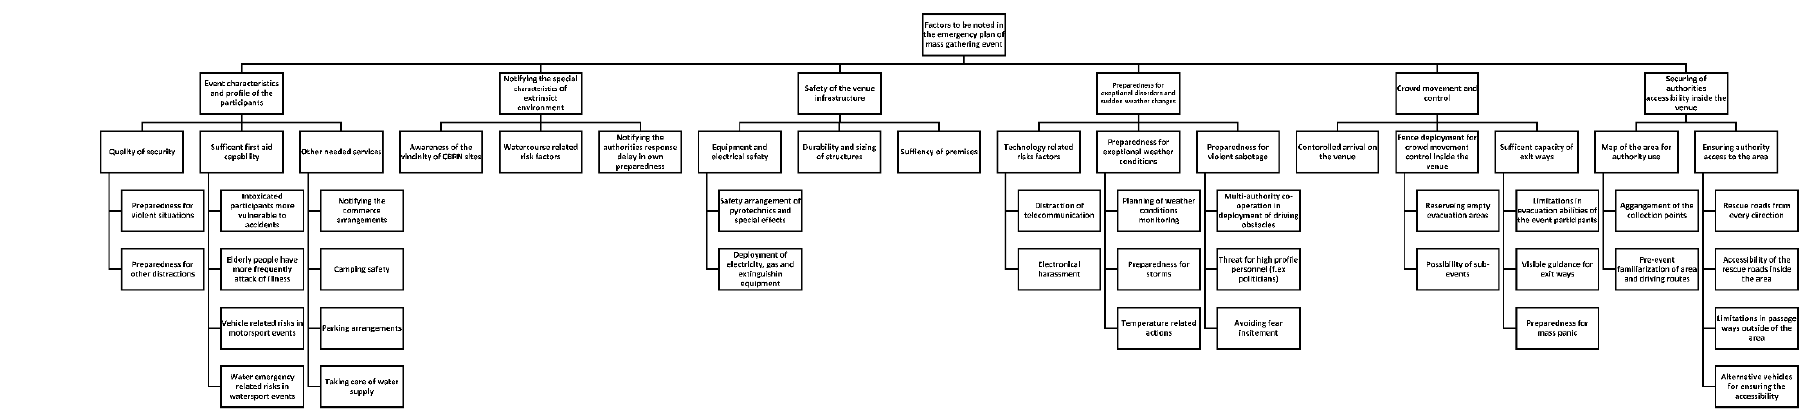
Figure 2. Co-operation in pre-planning phase and sub-categories.